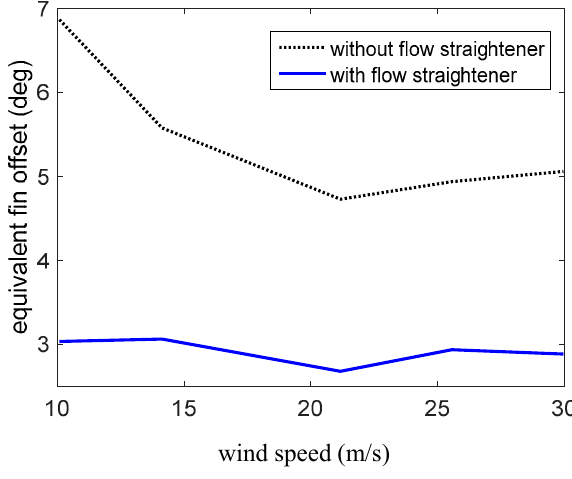
Figure 16. The equivalent fin offset versus velocity representing swirl in the wind tunnel.